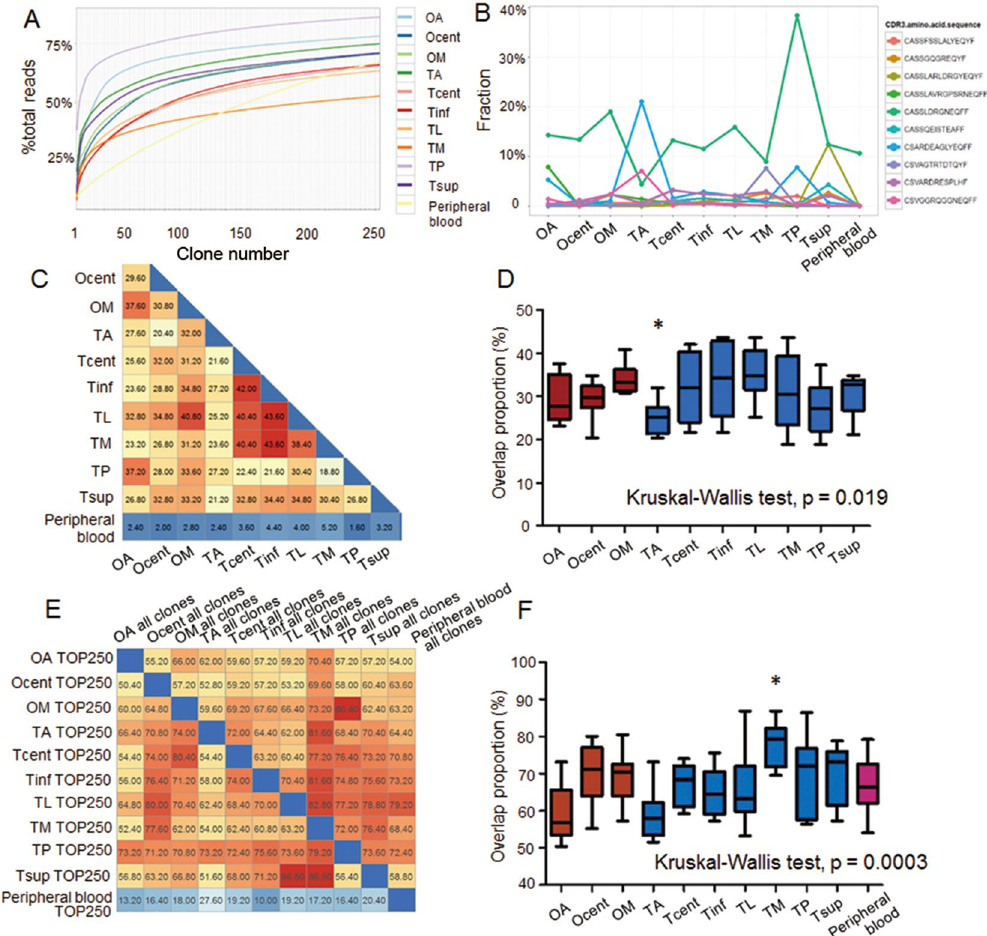
Figure 3. Distribution characteristics and heterogeneity of the TCR repertoires of Patient 1. ( A ) Cumulative size of the TOP250. The x-axis depicts the number of clones included (always starting from the most expanded clones). The y-axis shows the percentage of TCRB sequences that are covered by the included clones. ( B ) Frequencies of the ten most abundant common TCRB clones. The y-axis shows the percentage of the corresponding clone. The pairwise overlaps of the TOP250 among all samples are shown in ( C ). The boxplot of the overlaps of each sample with other samples according to the results from ( C ) is shown in ( D ). The pairwise overlaps of the TOP250 in one sample with the entire repertoire of the other samples are displayed in ( E ). The boxplot of the overlaps of each sample according to the results from ( E ) is shown in ( F ). Significant differences are marked by an asterisk ( *